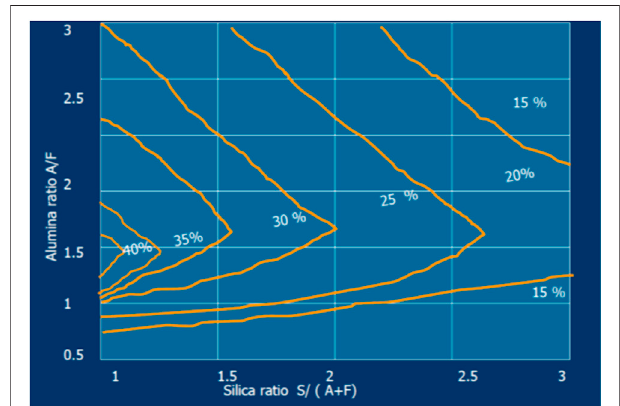
FIGURE 1 | Variation in % liquid phase at 1,338 ° C with change in silica ratio (SIM = S/[A + F]) and alumina ratio (AR) at LSF = 100, LSF = C/[2.8S + 1.1 A + 0.7F] (Kumar, 2013).